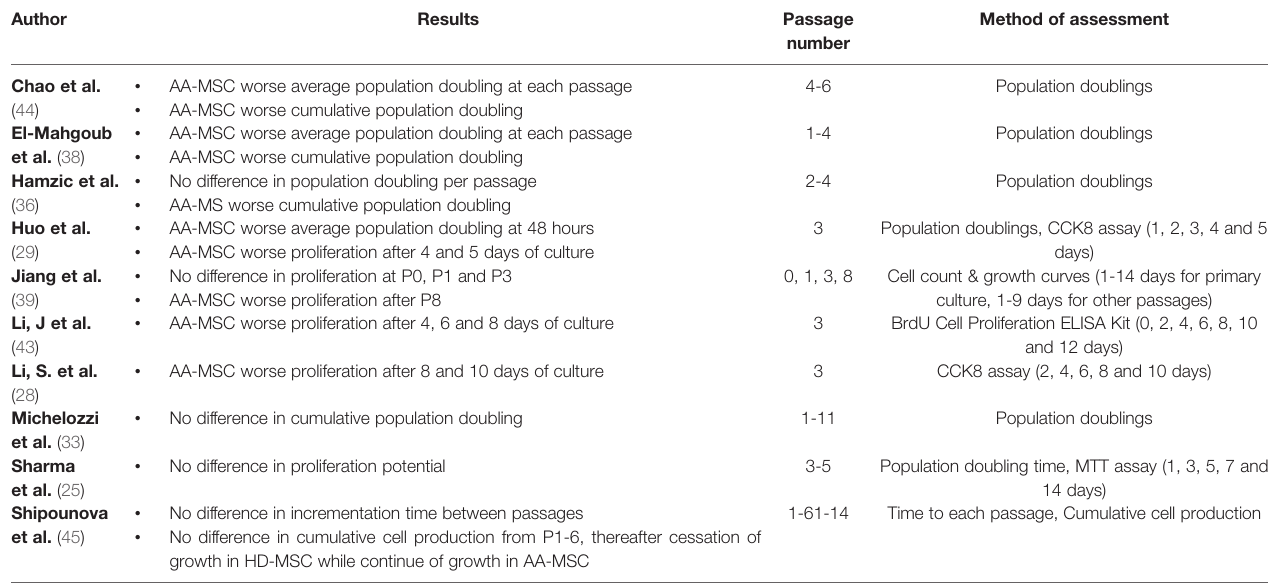
TABLE 5 | Assessment of proliferation potential.